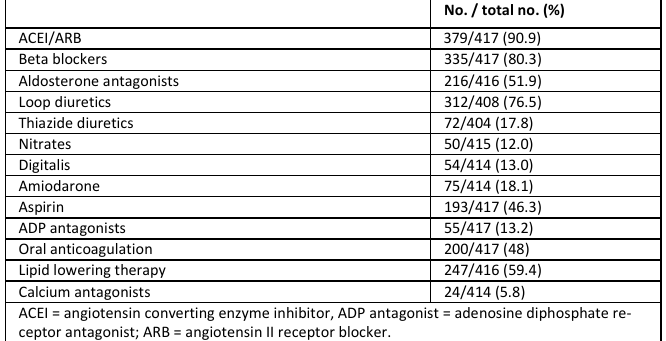
Table S2: Cardiac medication at the time of cardiac resynchronisation therapy device implanta- tion.